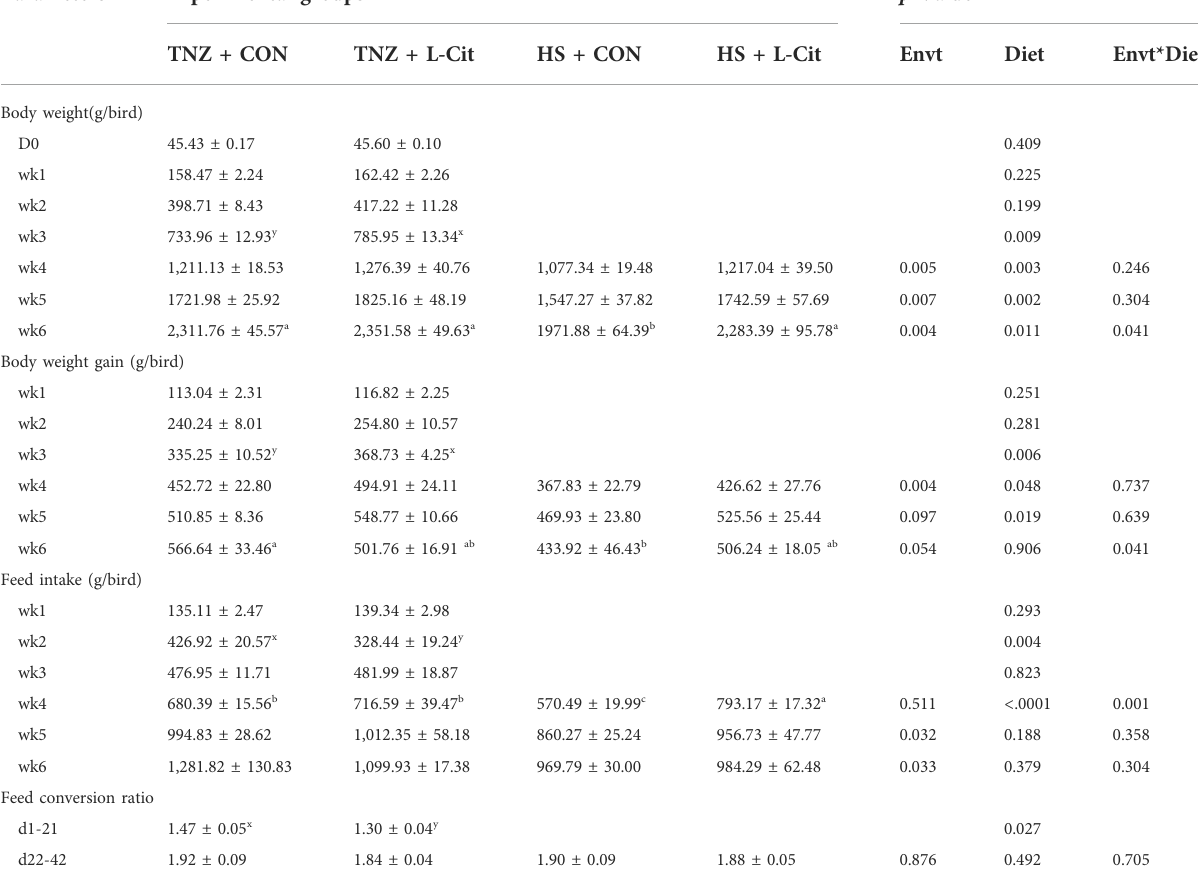
TABLE 3 Effects of heat stress and L-citrulline supplementation on the production performance of broilers.